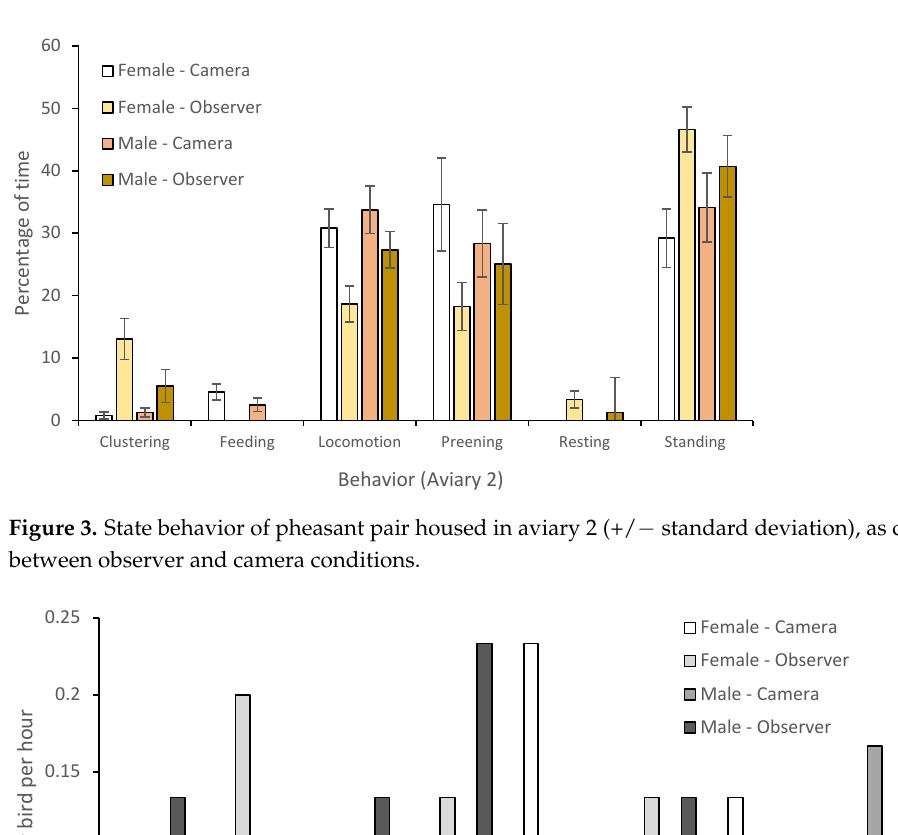
Figure 2. State behavior of pheasant pair housed in aviary 1 (+/ − standard deviation), as compared between observer and camera conditions.